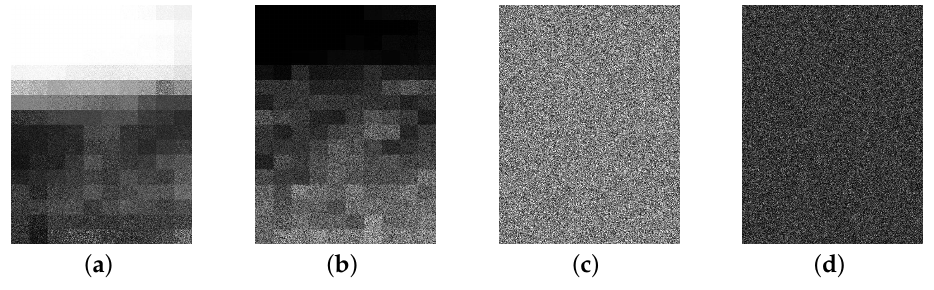
Figure 8. The procedure of disorder differential encryption. ( a ) Block disorder difference; ( b ) Value replacement; ( c ) Position permutation; ( d ) Encrypted